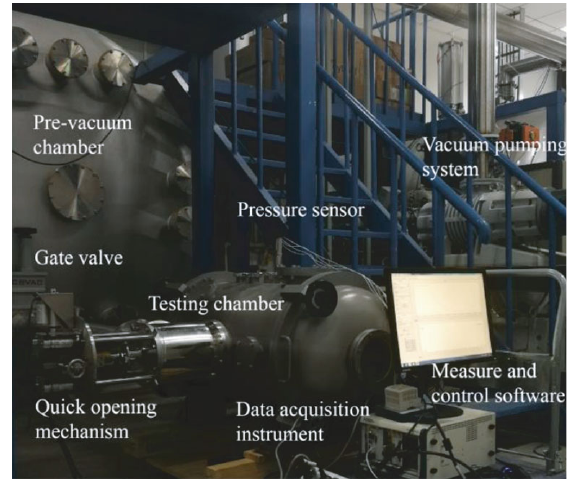
Figure 8: The veri fi cation